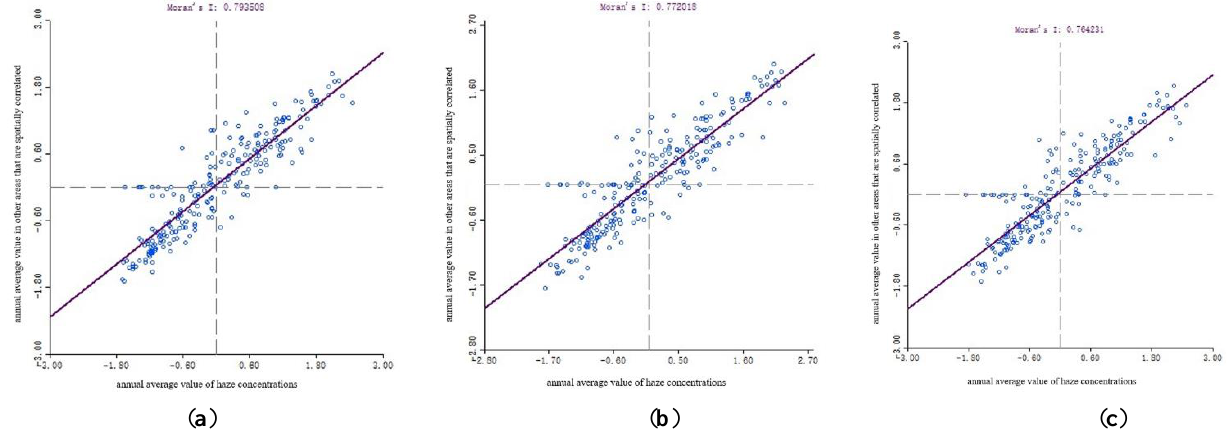
Figure 6. Scatter Plots of PM 2.5 in Prefecture-Level Cities in Some Years under the Geographical Proximity Weight Matrix. Source: Satellite Map of Global Annual Average Surface PM 2.5 Concentrations From SEDAC. The diagonal lines mean trend line of these scatter points. ( a ) Moran’s I scatter plot of PM 2.5 concentration values from 2001 to 2003. ( b ) Moran’s I scatter plot of PM 2.5 concentration values from 2005 to 2007. ( c ) Moran’s I scatter plot of PM 2.5 concentration values from 2010 to 2012.